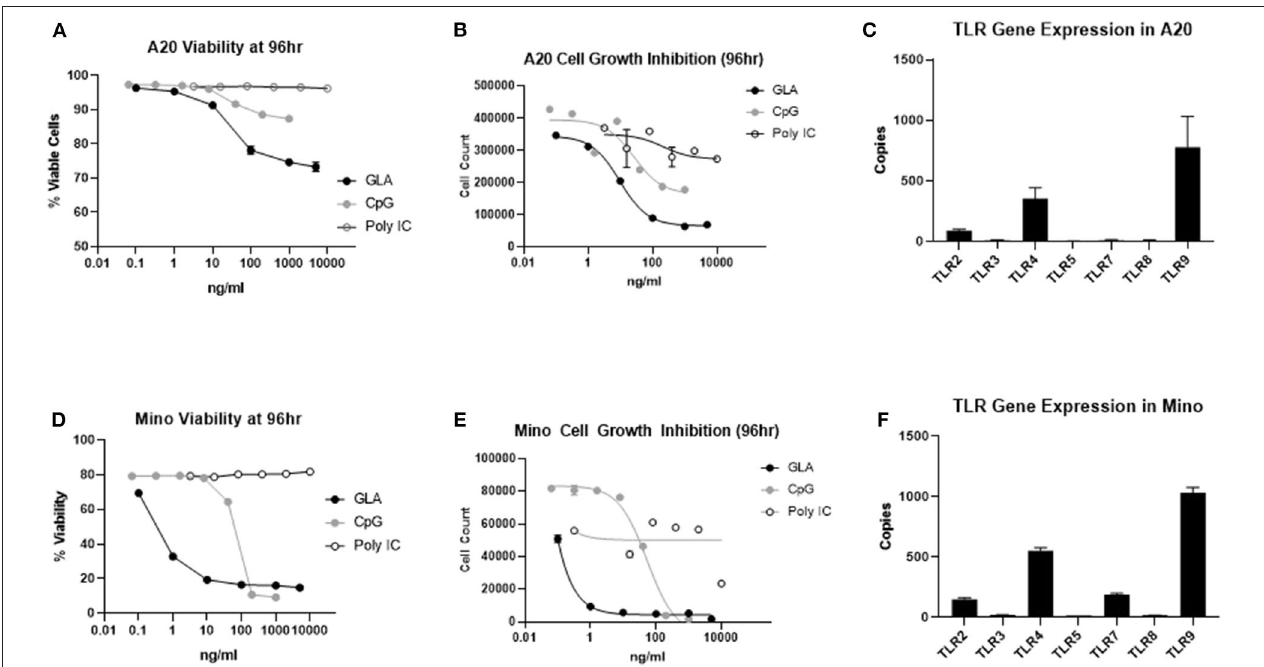
FIGURE 7 | A20 murine lymphoma and Mino human lymphoma cell lines are more sensitive to TLR4 agonist than TLR3 and TLR9 agonists. (A) GLA significantly inhibited the viability of A20 cells in vitro . Shown is the average viability of A20 cells (from two duplicate wells) at the given concentrations of GLA, CpG, or poly I:C. (B) GLA is more potent than poly I:C and CpG in inhibiting the growth of A20 cells. Shown are the average number of viable cells (y-axis) from two duplicate treatment wells at the given concentrations of GLA, CpG, or poly I:C (x-axis). (C) Expression level of different TLRs in A20 cells as determined by Nanostring gene expression assay using the panCancer Immune Profiling panel. Each bar indicates the expression level (mean ± sem) of a specific TLR gene in two independent RNA samples from A20 cells. (D) GLA significantly inhibits the viability of Mino cells. Shown is the average viability of Mino cells (from two duplicate wells) at the given concentrations of GLA, CpG, or poly I:C. (E) GLA is more potent than poly I:C and CpG in inhibiting the growth of Mino cells. Shown are the average number of viable cells (y-axis) from two duplicate treatment wells at the given concentrations of GLA, CpG, or poly I:C (x-axis). (F) Expression level of different TLRs in Mino cells as determined by Nanostring gene expression assay using the panCancer Immune Profiling panel. Each bar indicates the expression level (mean ± sem) of a specific TLR gene in two independent RNA samples from Mino